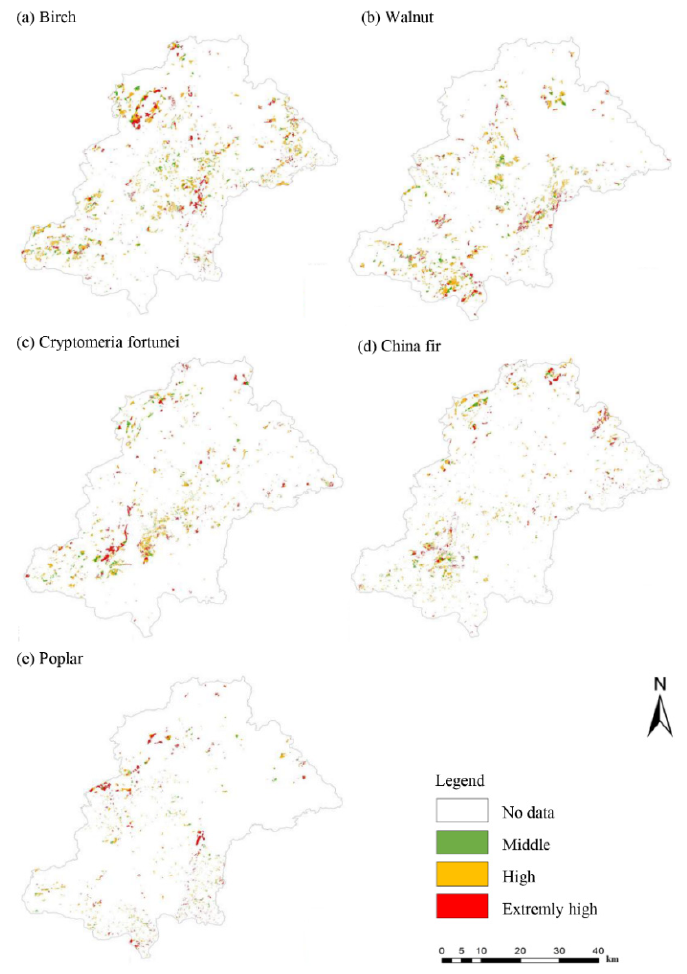
Figure 8. Spatial distribution map of landslide susceptibility of dominant tree species in Dafang County.